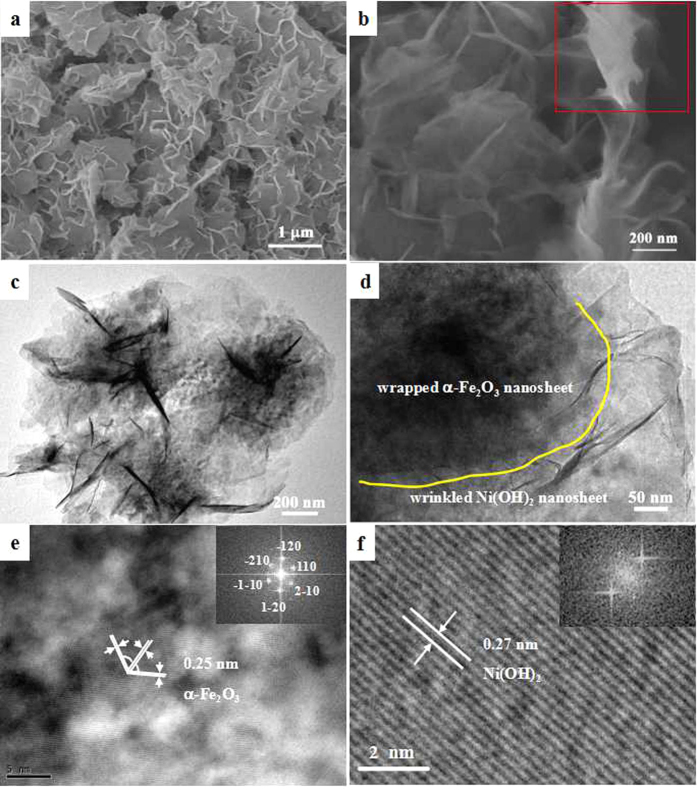
(a,b) SEM images and (c,d) TEM images and (e,f) HRTEM images of α-Fe2O3@Ni(OH)2 nanosheet hybrids.